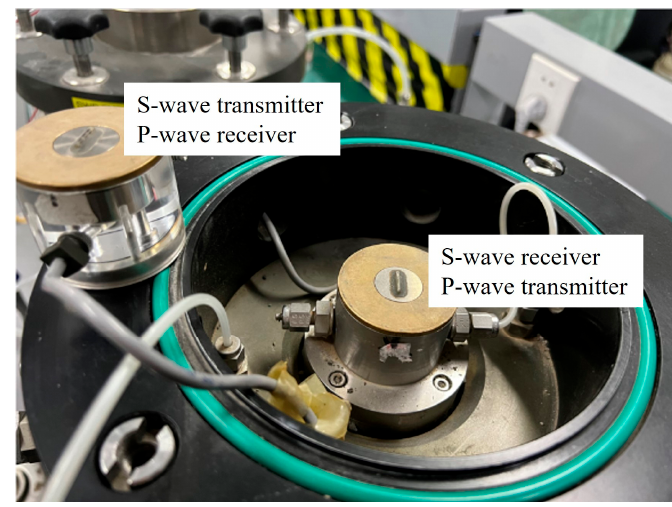
Figure 4. Bender–extender element